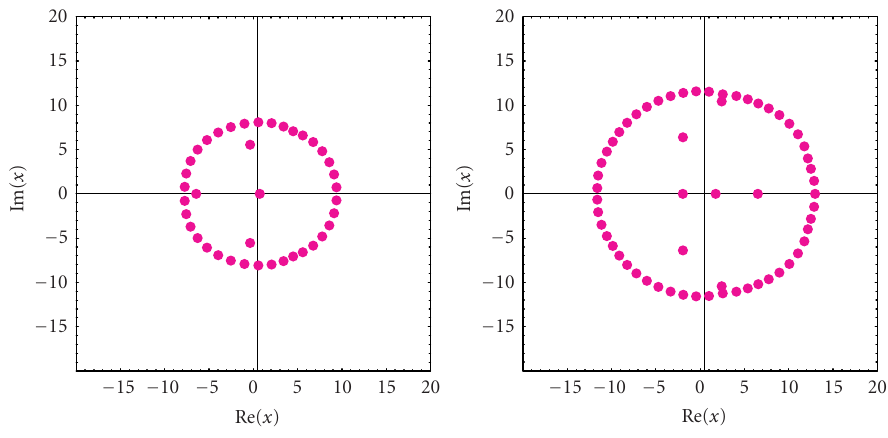
Figure 3.4. Zeros of q -Bernoulli polynomials β m ( x ,1 | 11 / 10), m = 40,60, and x ∈ C .